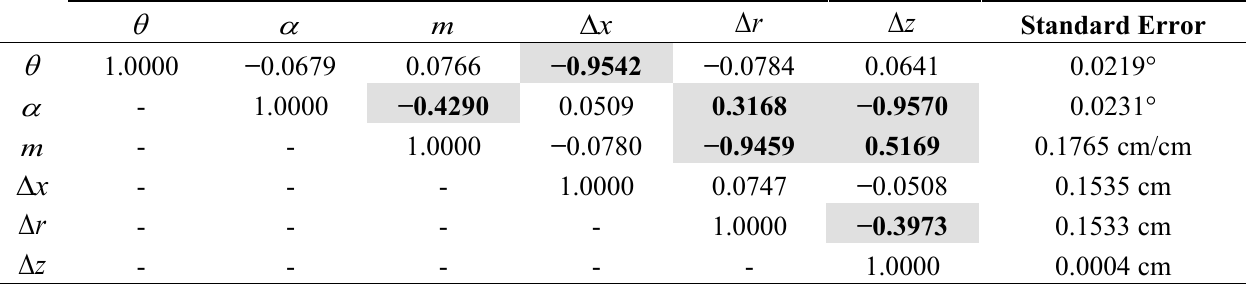
Table 4. Average correlation matrix and estimated error of non-linear